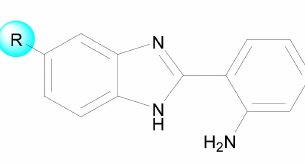
Figure 1. General structure of 2-(2-aminophenyl)-5(6)-substituted-1 H -benzimidazole molecules holding the key structural functional groups, proposed by the developed pharmacophore